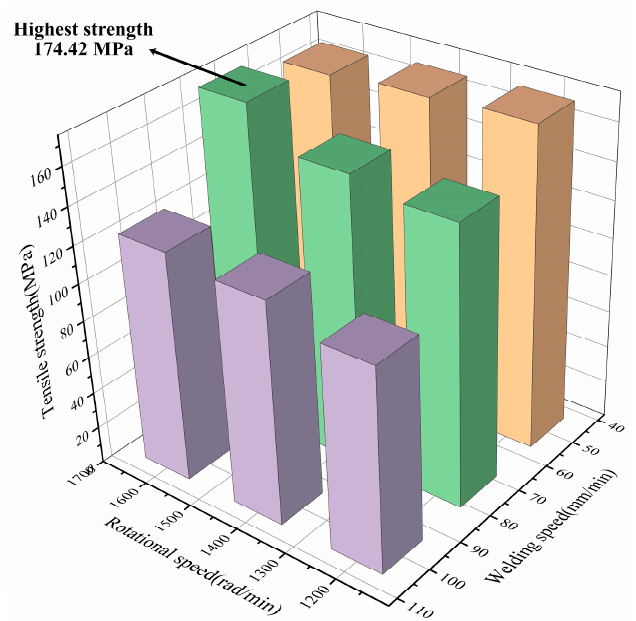
Figure 5. Relationship between welding speed, rotational speed, and the tensile properties of the joint.